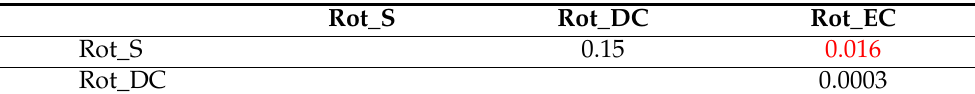
Table A4. Pairwise Wilcoxon rank sum test results for No_imagination. The number is marked red when it is statistically significant ( p < 0.05)